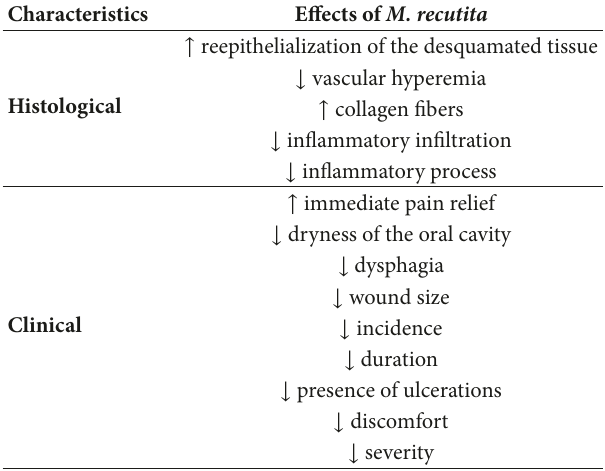
Table 5: Effects of Matricaria recutita